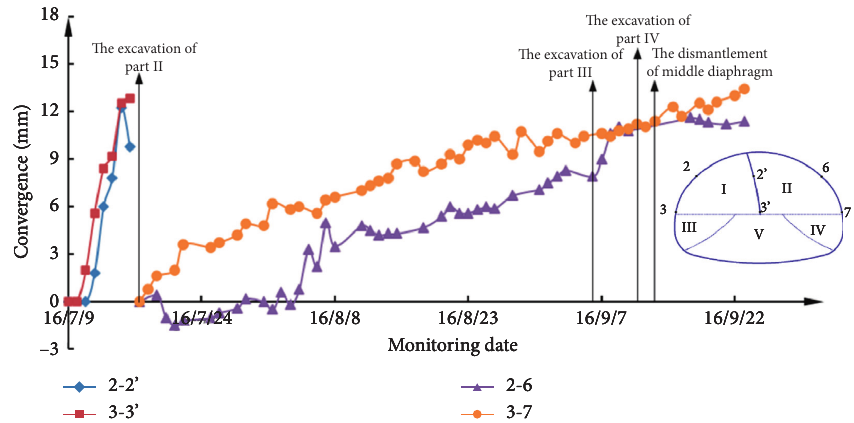
Figure 9: Temporal diagram of horizontal convergence.